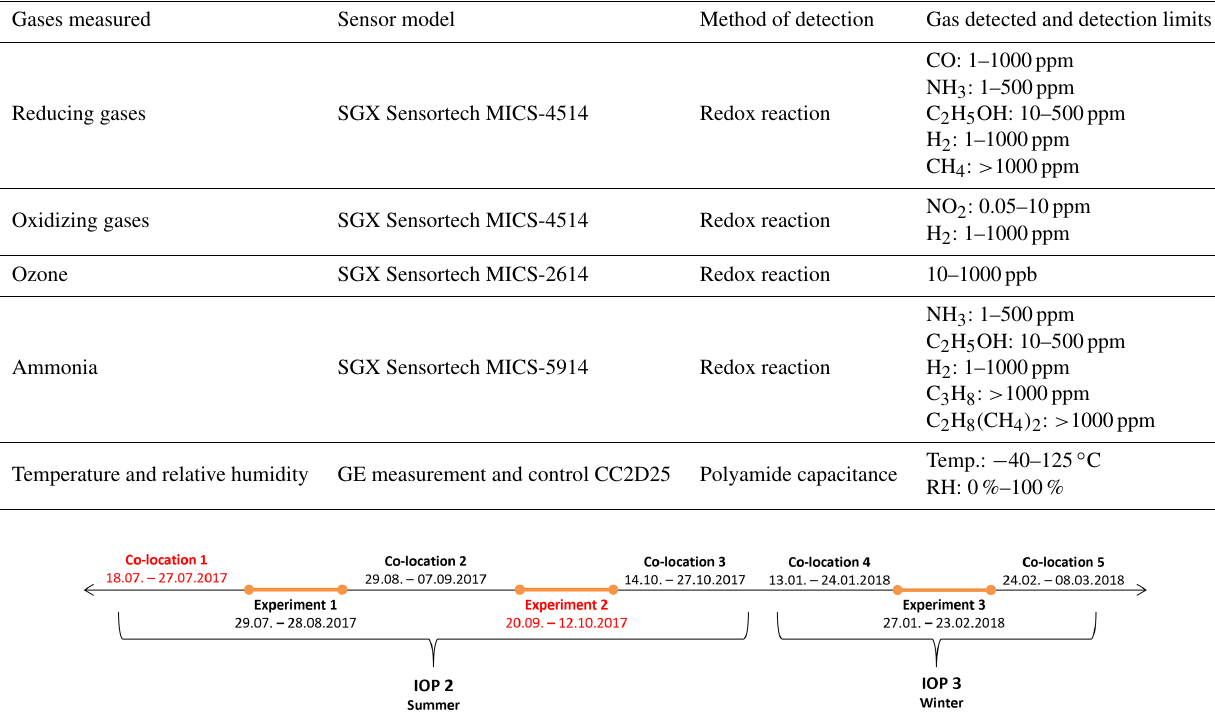
Figure 2. Timeline of SC and WC depicting the relationship between co-locations and experiments. Due to technical issues of individual instruments, data were unavailable for the segments marked in red.